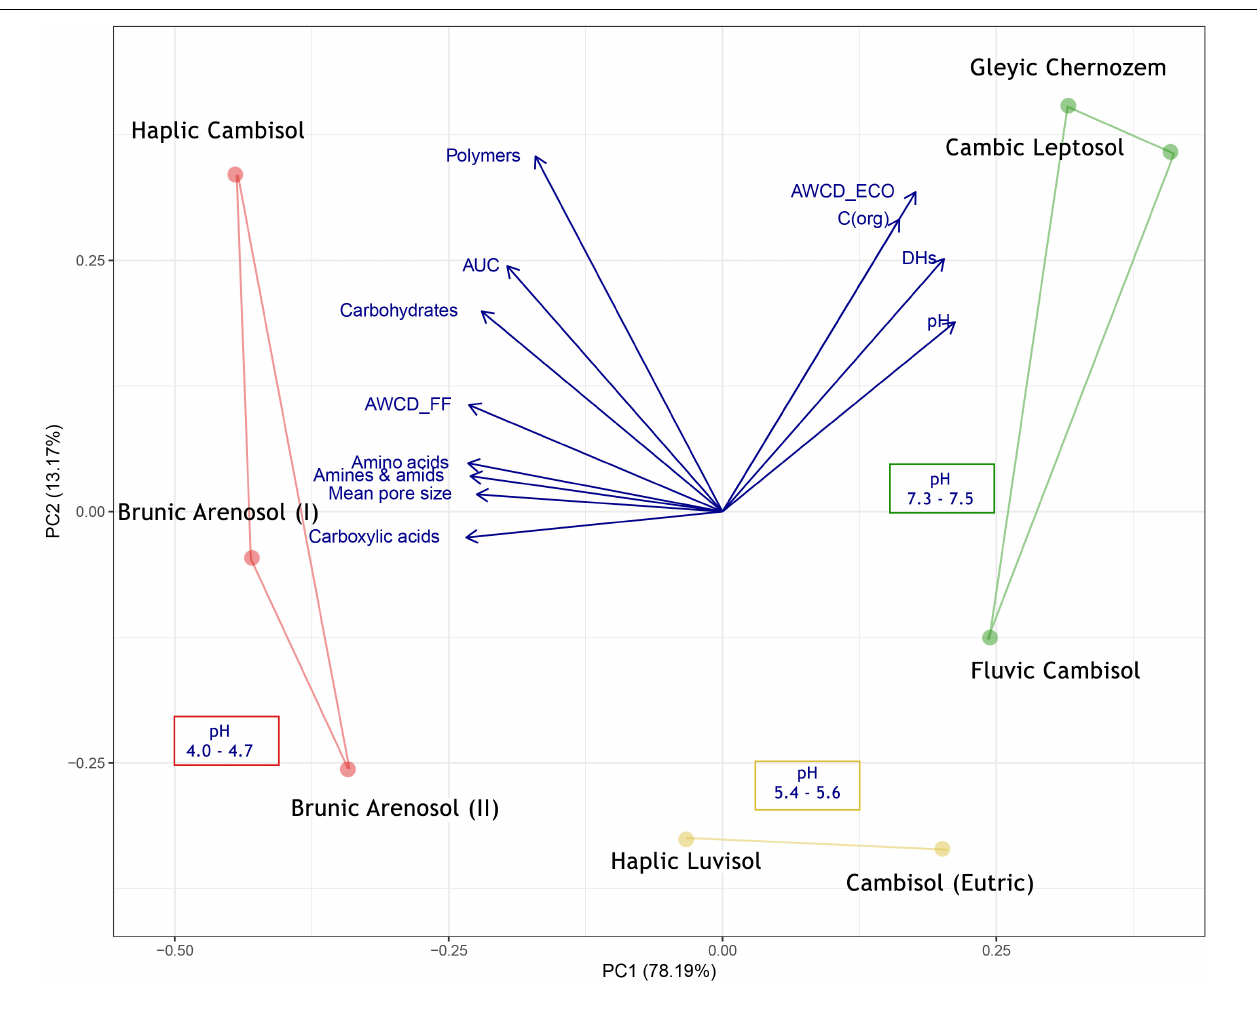
FIGURE 7 | PCA (Principal Component Analysis) of soil 11